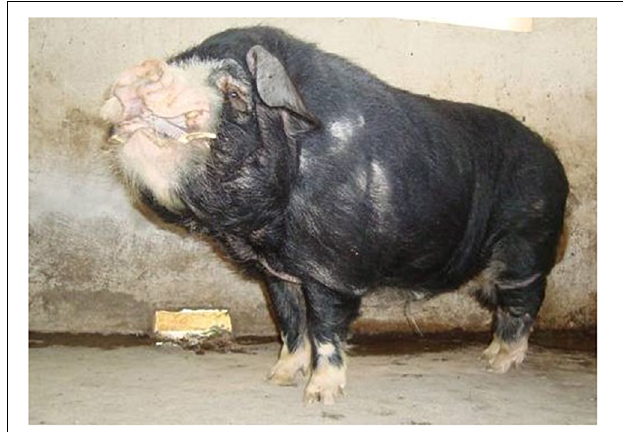
FIGURE 1 | Anqing six-end-white pig used in this